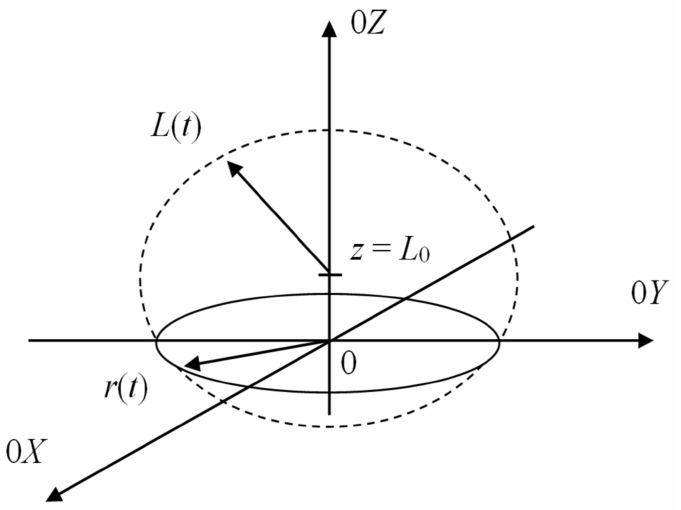
Figure 3. Scheme of the spherical shock wave action to the flat surface of